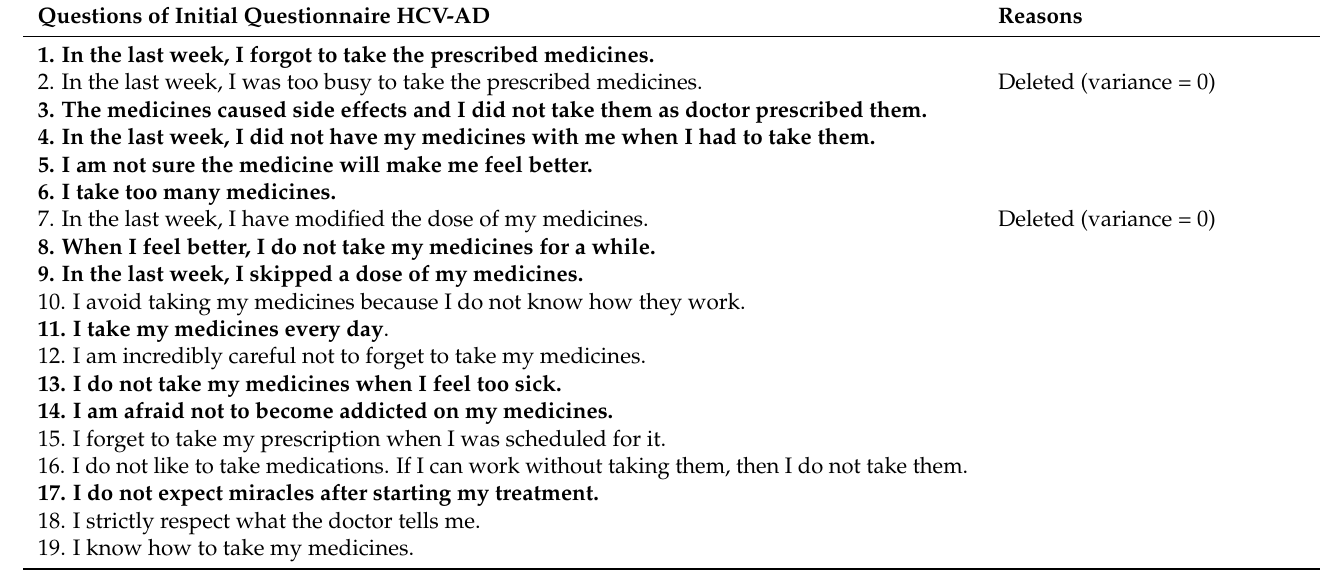
Table 2. The HCV-AD19.